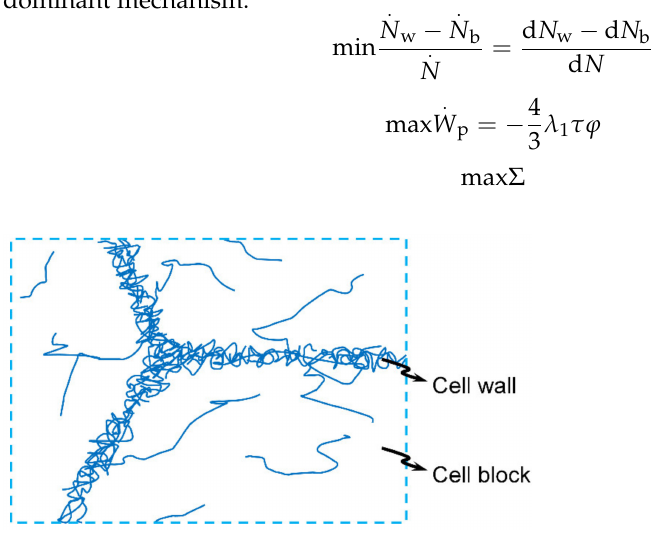
Figure 2. Illustration of the two-phase distribution of